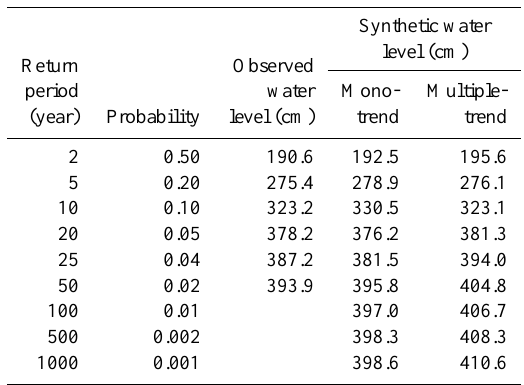
Table 2. Observed and synthetic maximum lake water